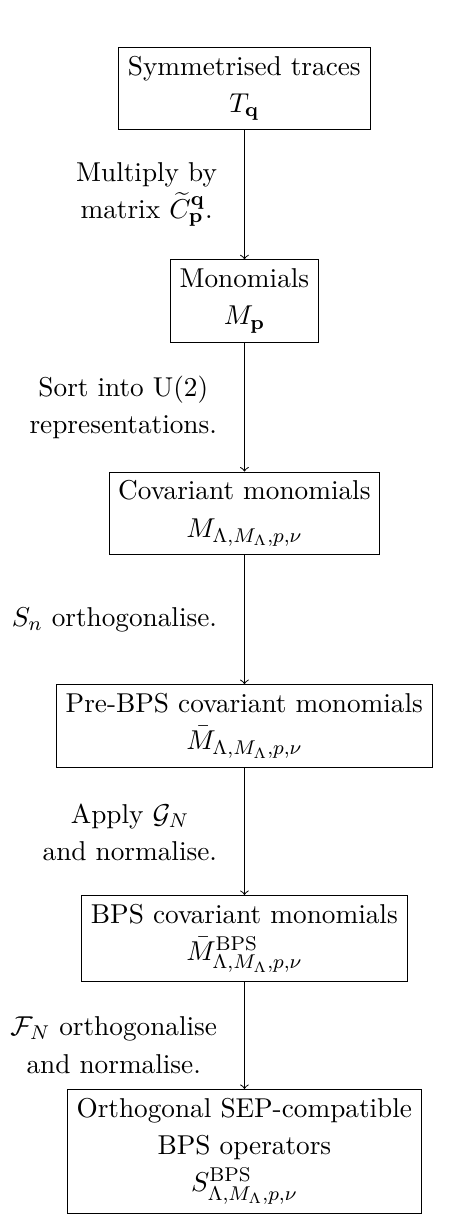
Figure 2 . An outline of the algorithm presented in this paper starting with symmetrised trace operators T and deriving a U(2) covariant, orthogonal, SEP-compatible basis S BPS for BPS p Λ ,M Λ ,p,ν operators when N < n . The first step is studied in detail in section 4, the second step in section 5 and the last three steps in section 6. All normalisations are with respect to the S inner product. n Note that any algorithm to derive S BPS need only involve one normalisation step at the very Λ ,M Λ ,p,ν end. The extra normalisation step is included in the figure in case the desired output is ¯ M BPS Λ ,M Λ ,p,ν